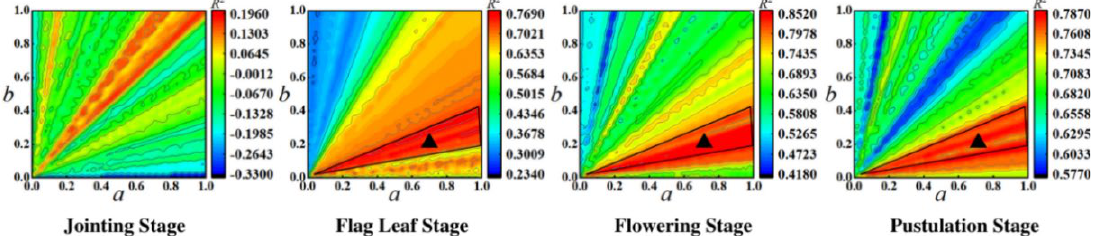
Figure 6. The prediction results of winter wheat yield in different a and b .